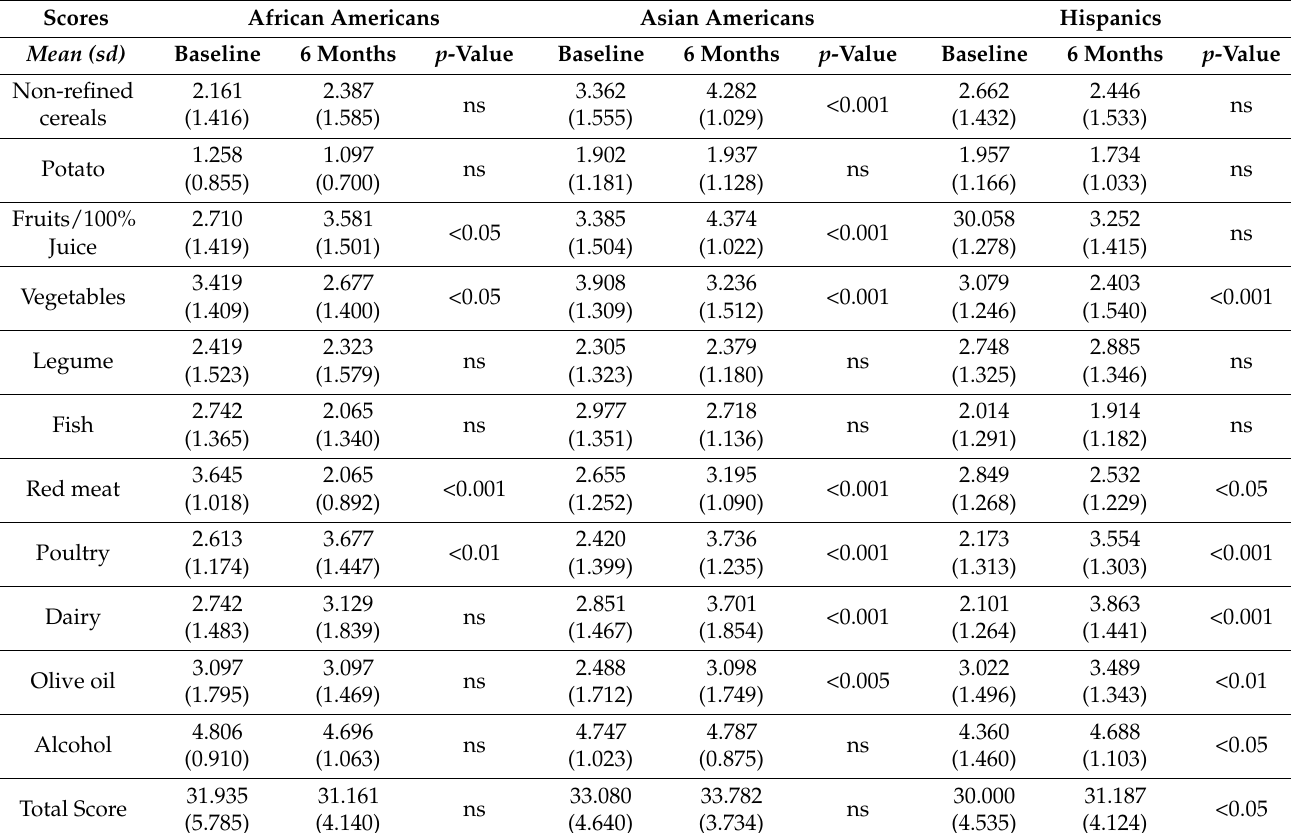
Table 2. Comparison of dietary scores among three groups at baseline vs. 6 m follow